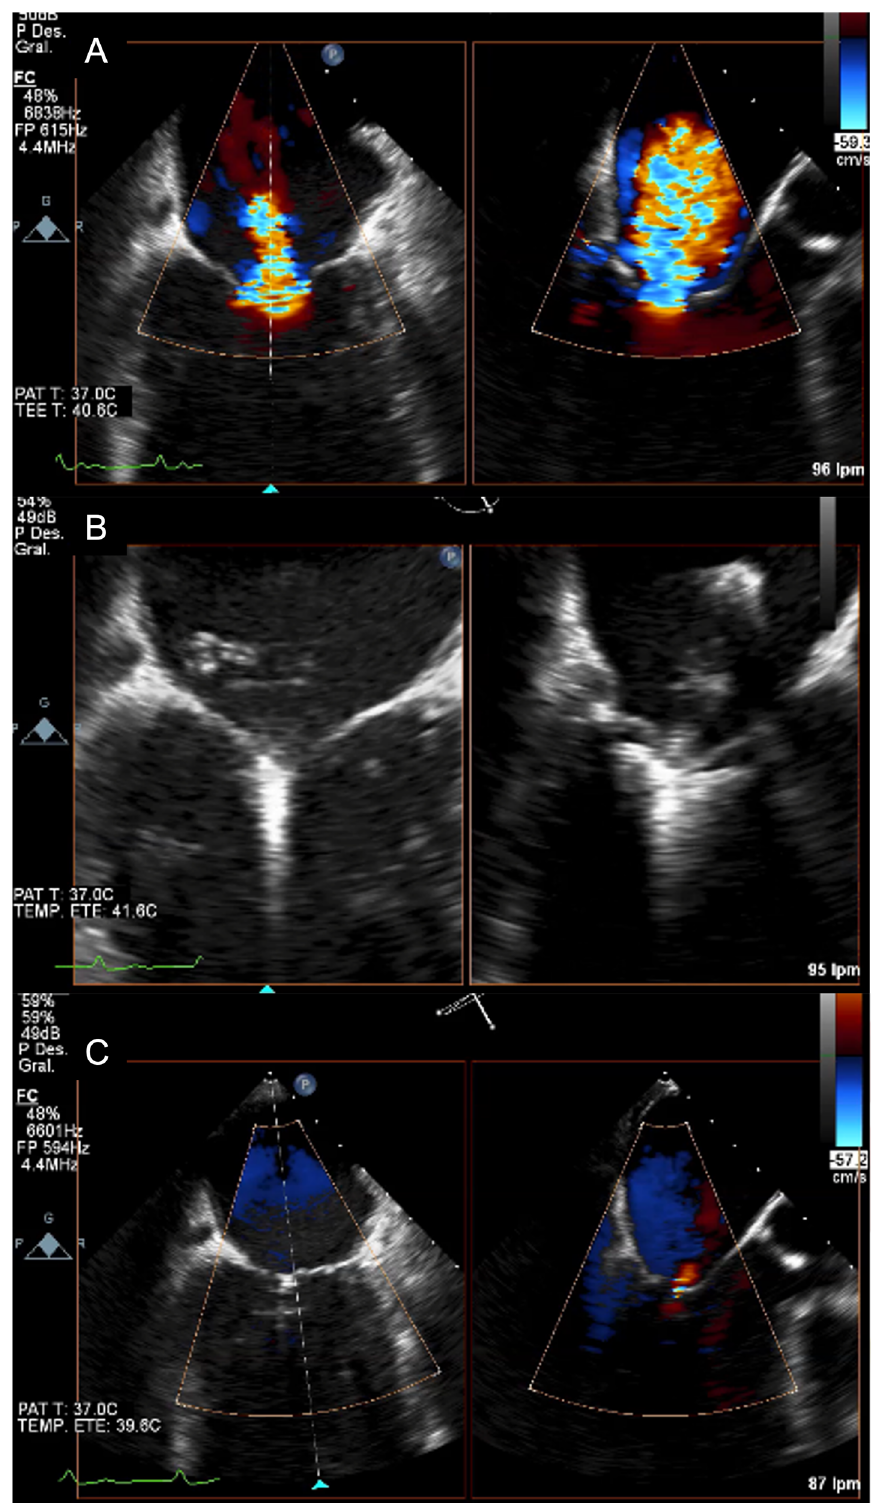
Figure 3. ( A ) Transoesophageal echocardiographic: colour Doppler demonstrating severe mitral regurgitation in a patient with acute MR. ( B ) Transoesophageal echocardiographic: grasping with a MitraClip XT device. ( C ) Transoesophageal echocardiographic: final result: trace MR.